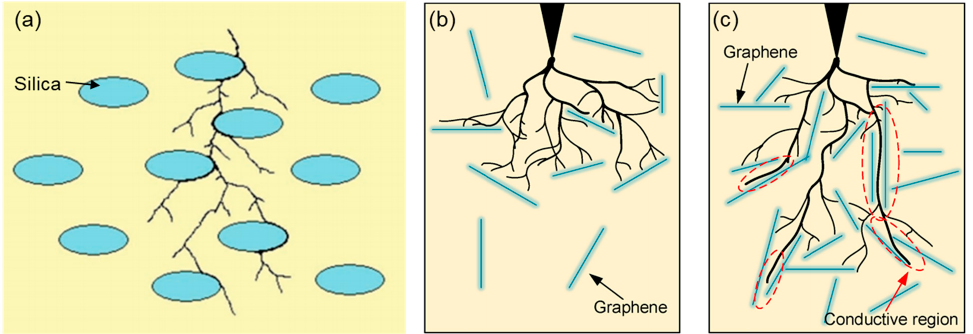
Figure 7. Schematic diagram of electric tree growth through ( a ) polymer/insulating silica particle composite with good particle dispersion, and ( b , c ) a polymer/graphene composite in which graphene within a local area is ( b ) at low concentrations and evenly dispersed or ( c ) at higher concentrations and poorly dispersed. In ( a ), tree growth proceeds in the area without particles but is hindered near the polymer/particle interface. Treeing process strongly depends on particle dispersion if conductive particles such as graphene are used. ( b ) Graphene is locally well-dispersed and tree formation is inhibited by electric field distortion along the polymer/graphene interface. ( c ) Local graphene agglomerates create locally conductive regions (highlighted in red) with lower dielectric strength that accelerate electrical treeing. Figure ( a ) is adapted with permission from Ref. [3]. Copyright © 2009, IEEE. Figures ( b , c ) are adapted with permission from Ref. [27]. Copyright © 2019 by the authors.